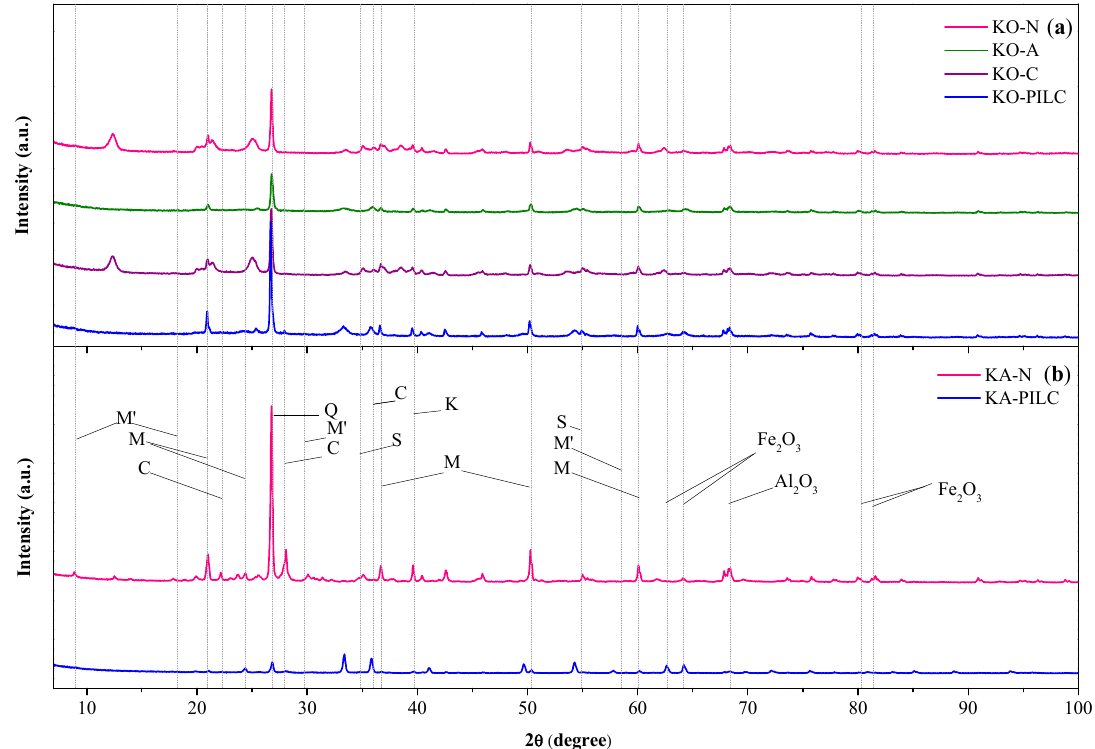
Figure 2. XRD spectra of ( a ) Kokshetau and ( b ) Karatau based clays (M = Montmorillonite, S = Saponite, K = Kaolinite, M ′ = Muscovite, C = Calcite, Q = Quartz).